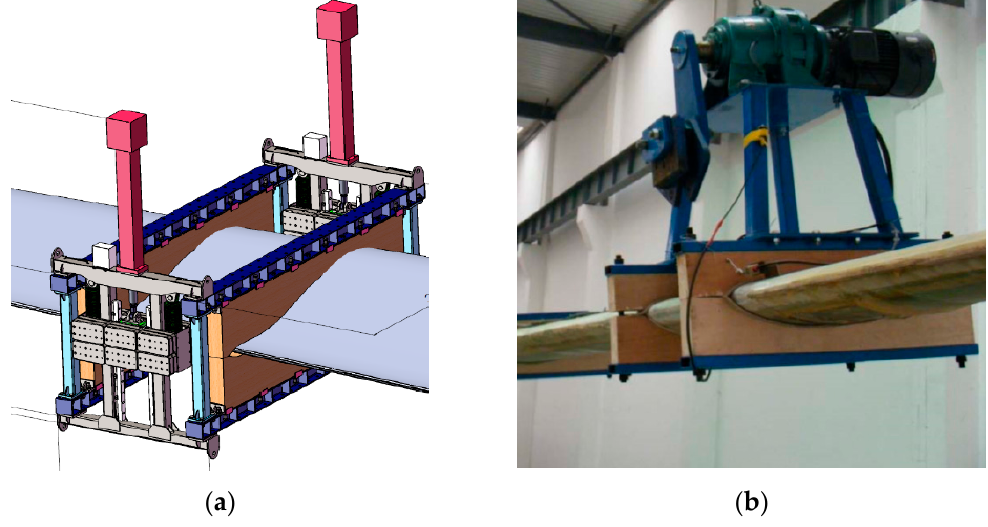
Figure 1. Comparison of two types of loading systems: ( a ) Linear exciter loading system; ( b ) Rotation pendulum loading system.